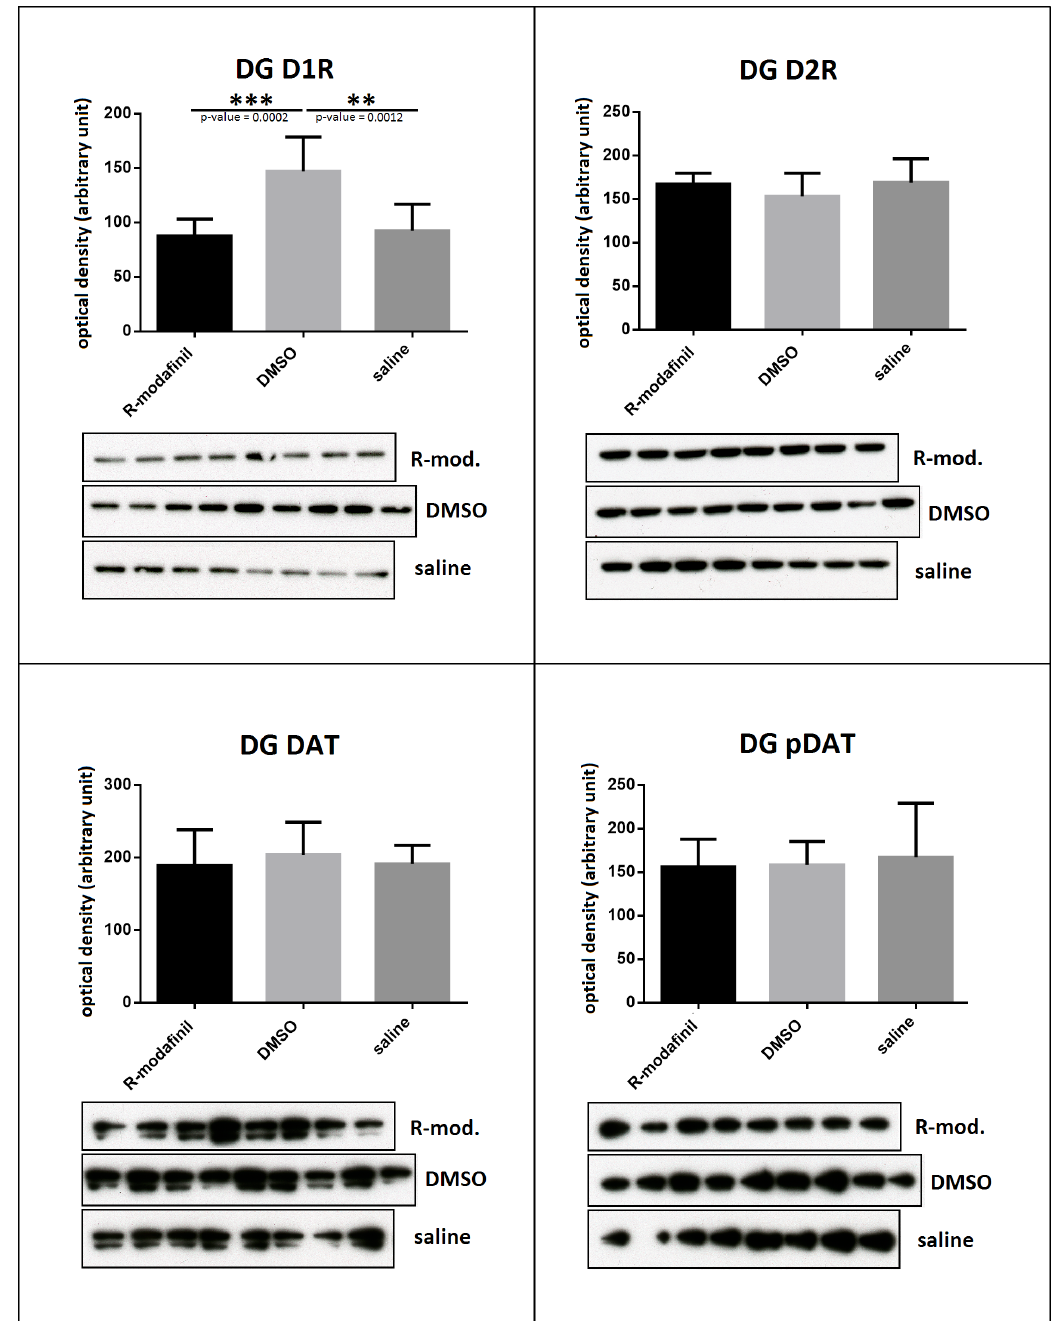
Fig 5. DMSO and R-MO diametrically modulate D1 receptor levels in the dentate gyrus: Synaptosome fraction of the dentate gyrus tissue was analyzed in western blots post LTP induction, probed for D1 (100 kDa), D2 (50 kDa), DAT (115 kDa) and DAT-phospho (75 kDa). D1 levels were significantly increasedDMSO treated rats comparedto the saline and R-MO (dissolvedin DMSO) treated rats. There were no differences in other receptor or transporter levels analyzed.Student’s T-test statistical analysiswas performed.Graph indicatedmean ± SD. ** p < 0.005, *** p < 0.001.